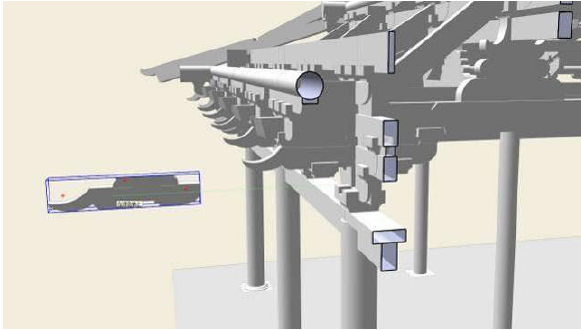
Figure 7 A construction member in group of "dou